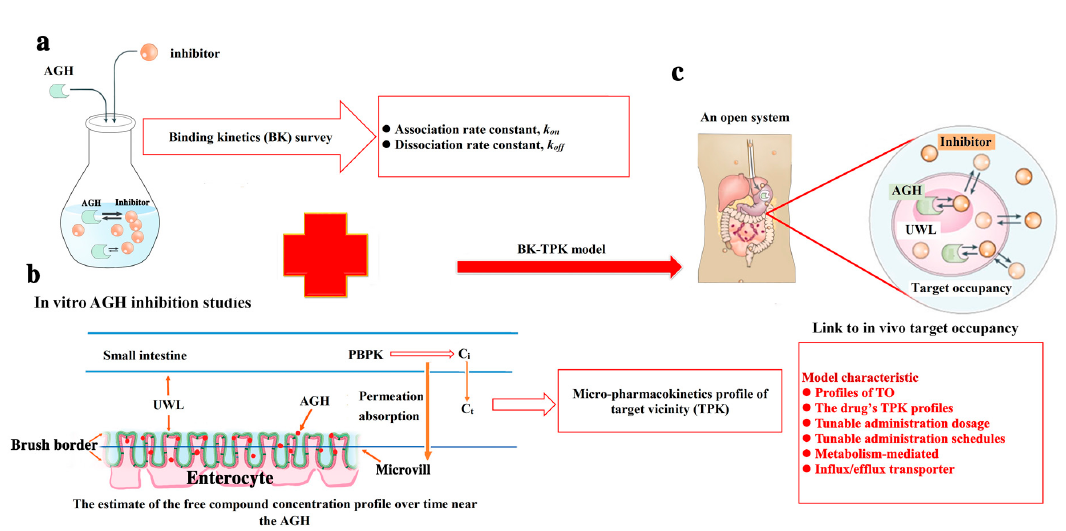
Figure 1. The overall framework of the binding kinetics-micro-pharmacokinetics of free compound in the target vicinity (BK-TPK) model. ( a ) The values of k on and k off of compound- α -glucosidase (AGH) interaction in in vitro were obtained based on binding kinetics method. ( b ) AGH (red solid circle) is synthesized in the enterocyte and subsequently released and distributed on the surface of the microvilli in the brush border region of the small intestine. Compound molecule in the intestine tract diffuses into the unstirred water layer (UWL) (corresponding to AGH target vicinity) by passive permeation absorption and then bind to the AGH to inhibit the enzyme activity. The concentration change of compound imping on the AGH with time (i.e., C t ) can be calculated using TPK model developed. ( c ) Studies of compound-AGH interplay in in vitro and TPK model were combined to develop the BK-TPK model to evaluate the time course of AGH-engagement in in vivo by different compound molecules. The major characteristics of this model were presented in the red box.